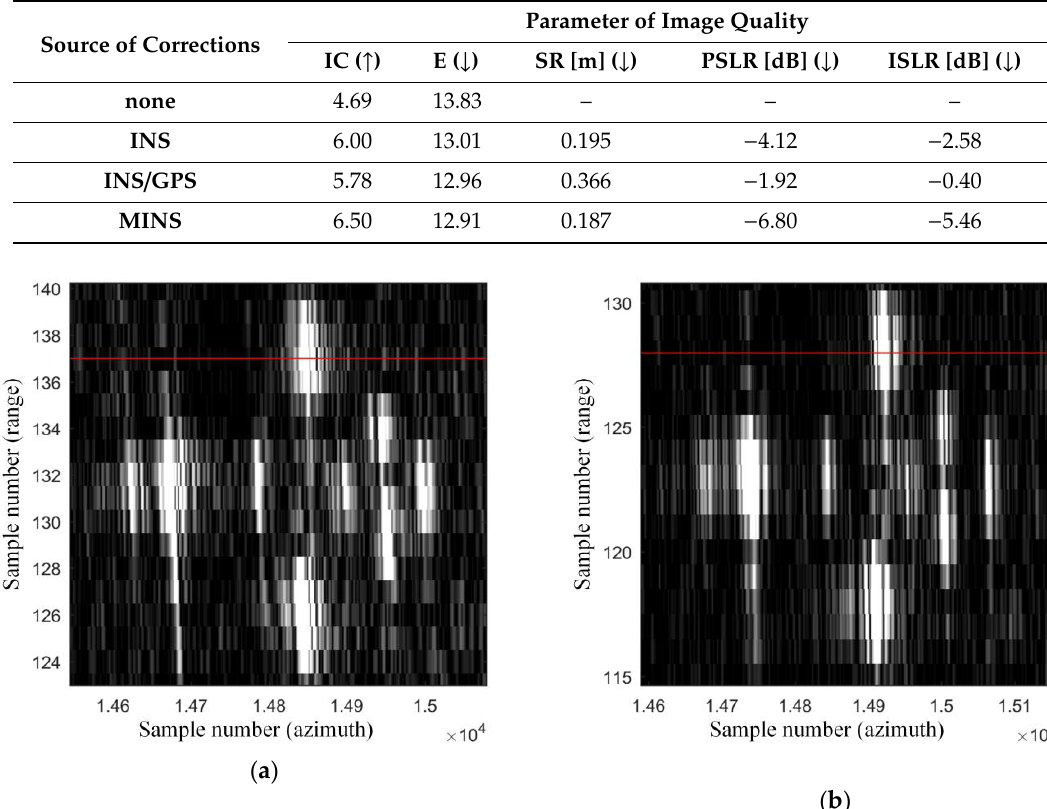
Figure 21. Image of the arrow made of corner reflectors for flight no 2: ( a ) with the INS-based MOCO, ( b ) with the MINS-based MOCO; red line—an analyzed row.